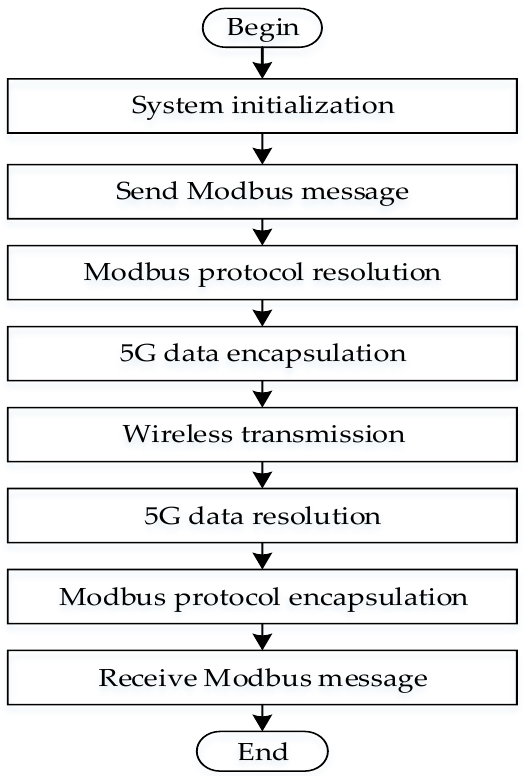
Figure 4. The protocol adaptation process between 5G and Modbus.